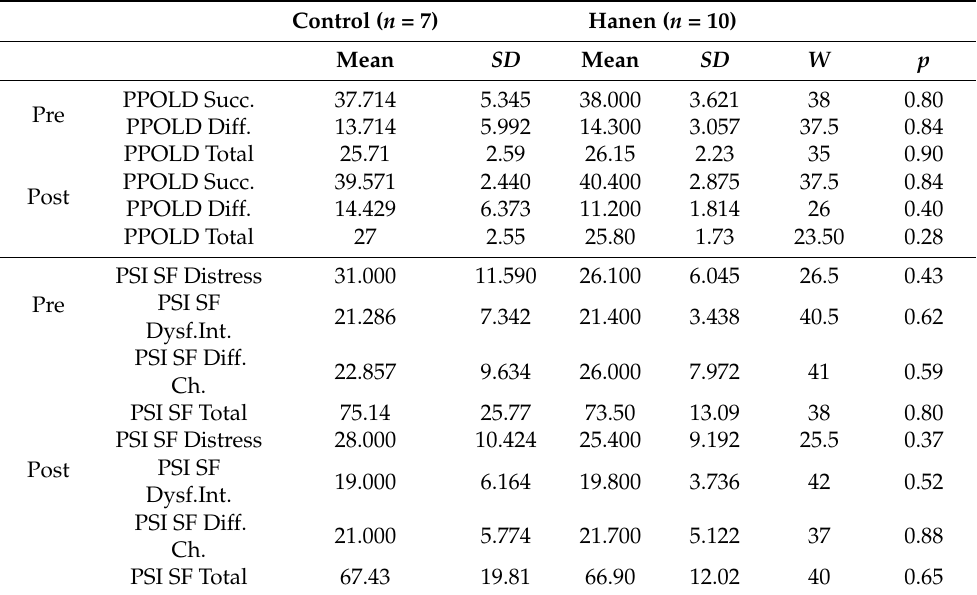
Table 4. Descriptive statistics relating to parents and Mann-Whitney nonparametric U test across